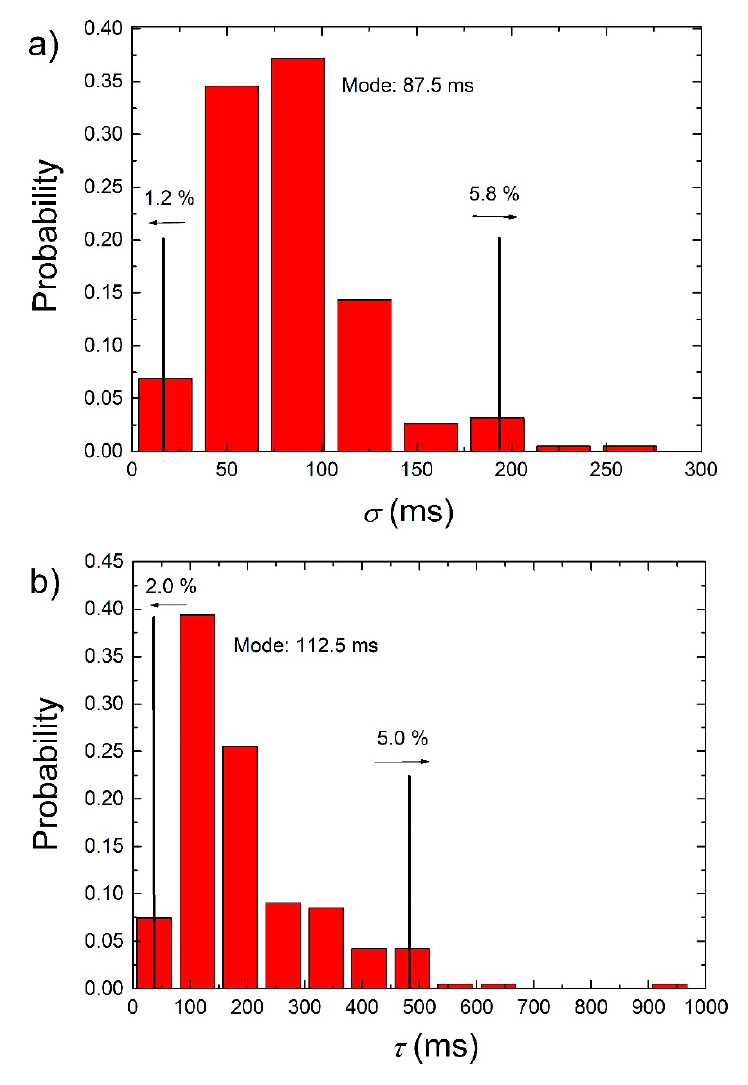
Figure 6. Probability distributions of σ ( a ) and τ ( b ) parameters in an ex-Gaussian representation of the data.